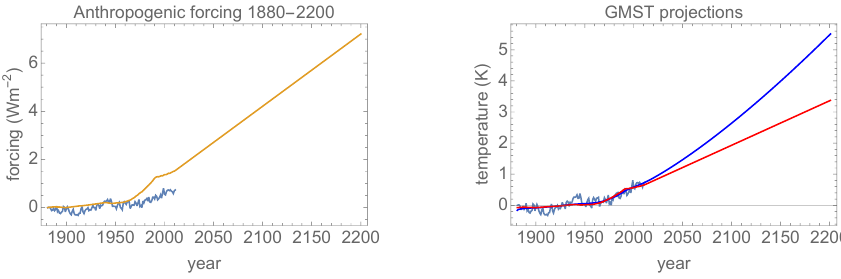
Figure 1. The light blue curves in both panels are observed global temperature in the period 1880–2010CE. The orange curve on the left is the historic anthropogenic forcing extended with an exponential growth in atmospheric CO 2 concentration, ending at around 700ppm 100 years from now. The red curve on the right shows the projected temperature from a standard EBM with τ = 0, and the blue curve shows this from a fractional EBM with β = 0 . 75. The difference between the two projections in the year 2100CE is almost 1 ◦ C.